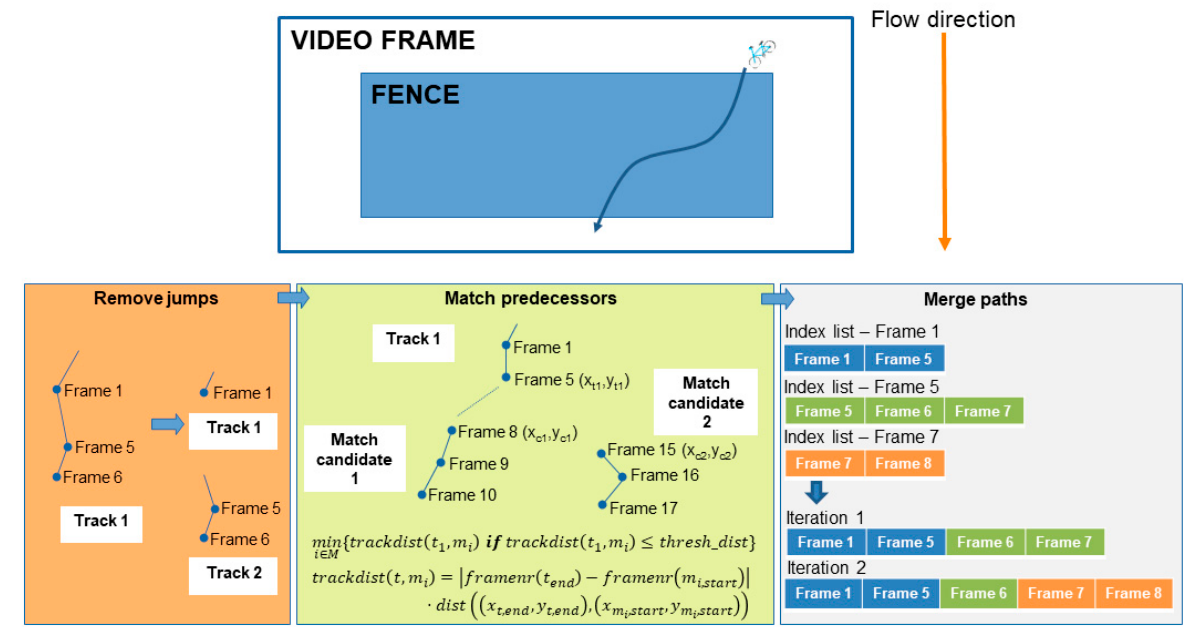
Figure 5. A schematic overview of the three-step pose tracking merging strategy.